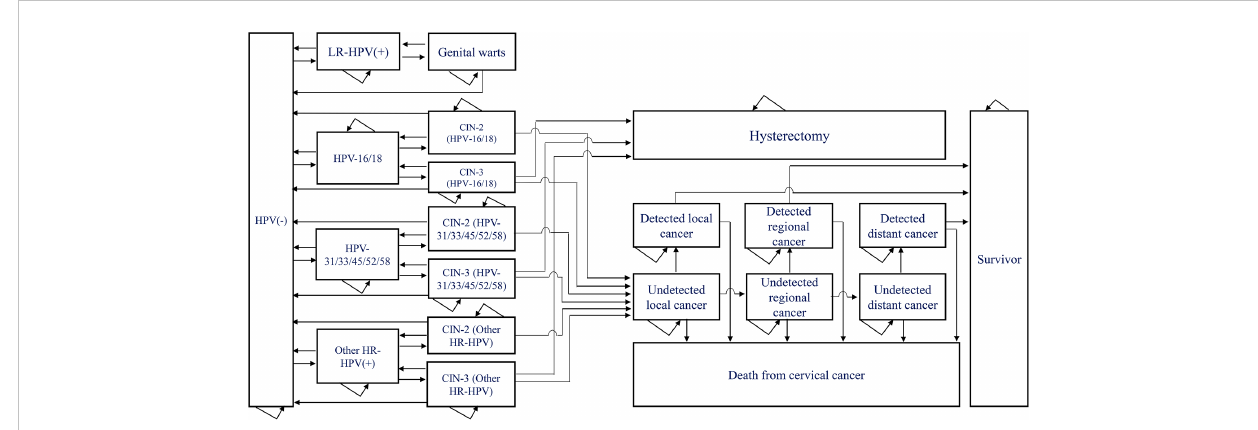
FIGURE 1 Markov model of the natural history of low and high risk type of HPV. HPV, human papillomavirus; CIN, cervical intraepithelial neoplasia; LR-HPV(+): HPV6/11 only, no other low-risk HPV infections considered; HPV-16/18(+): infected with HPV-16 alone, with HPV-18 alone or with both HPV-16 and 18; HPV-31/33/45/52/58(+): HPV-31, HPV33, HPV45, HPV52 or HPV58 alone, or co-infection with two or more of these fi ve types of HPV; Other HR-HPV(+): Infection with high-risk HPV types other than HPV16, HPV18, HPV-31, HPV33, HPV45, HPV52 or